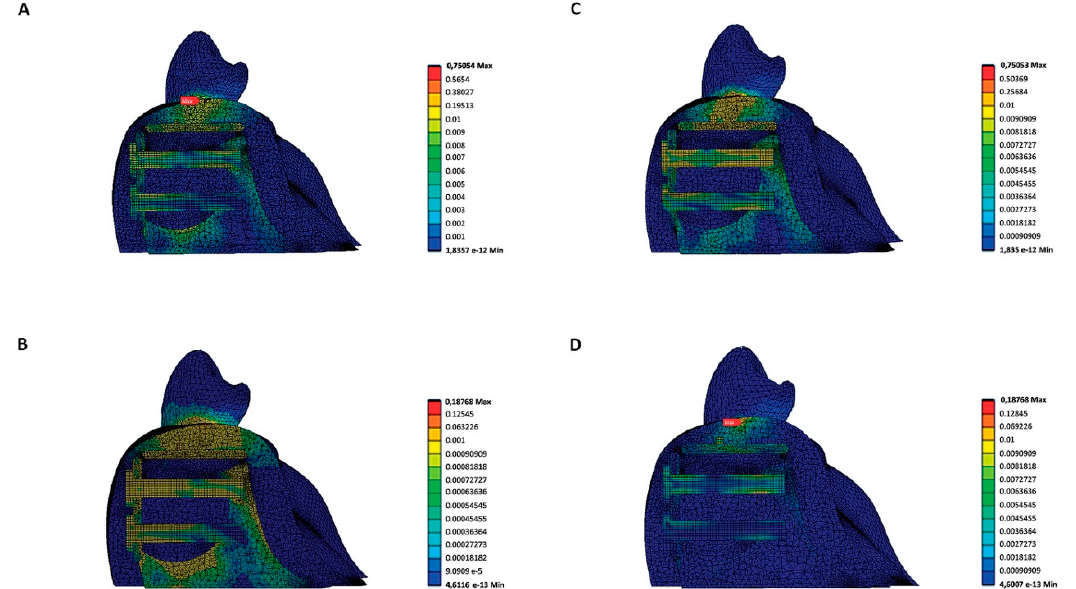
Figure 6. ( A ) lateral section of a stress distribution map for the different stresses and morphologies: A. stress distribution map for the right-angled model with 0.2 N force; ( B ) stress distribution map for the right-angled model with 0.05 N force; ( C ) stress distribution map for the rounded model with 0.2 force; ( D ) stress distribution map for the rounded model with 0.05 N force. The red arrow indicates the area of the greatest transferred stress (MPa) according to the Von Mises criterion.